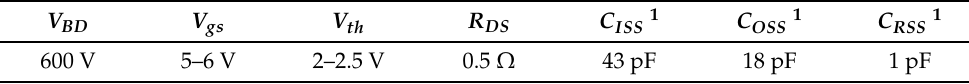
Table 1. DUT electrical